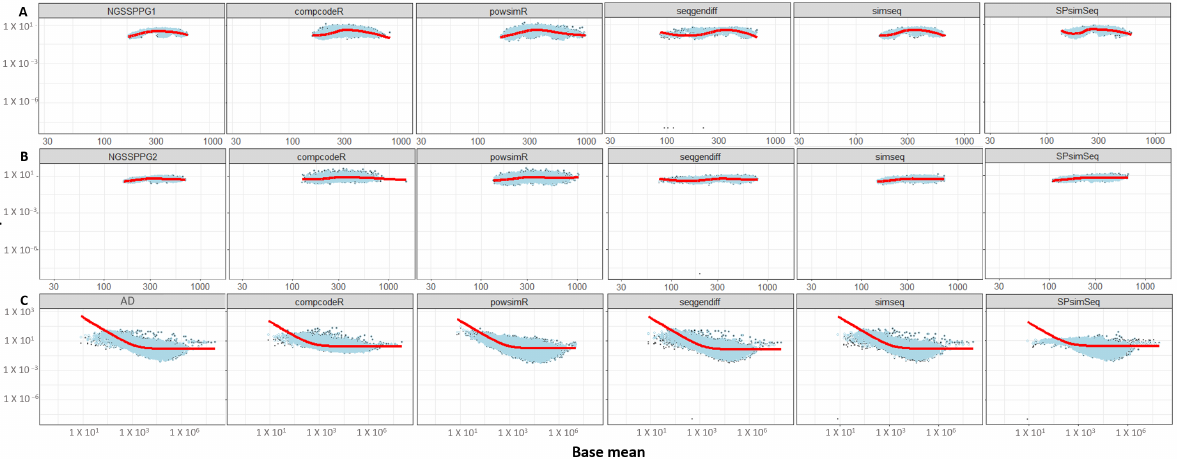
Figure 4. Dispersion vs. BCV plots of the: ( A ) NGSSPPG1; ( B ) NGSSPPG2; and ( C ) AD datasets and the datasets generated with these as input. Black dots: gene-wise dispersion estimates. Red curve: fitted mean-dispersion relationship. Blue circles: final dispersion